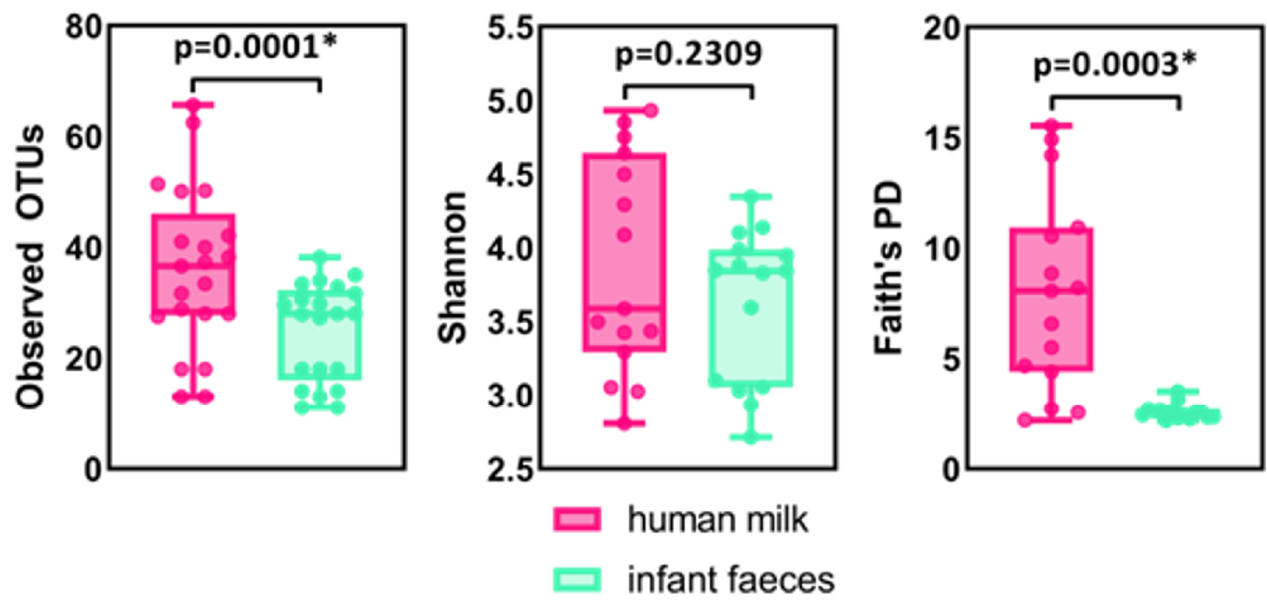
Figure 4. α -diversity boxplots summarising bacterial diversity of human milk and infant faecal samples using Observed OTUs, Faith’s phylogenetic diversity (PD) and Shannon indices. Asterisks (*) indicate a significant difference ( p < 0.01) in bacterial diversity between human milk and infant faecal samples. Statistical analysis was conducted using Two-Way ANOVA.